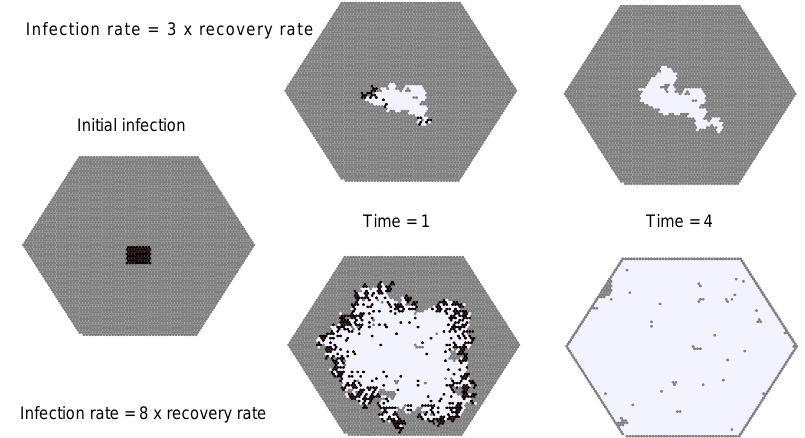
Figure 10. A susceptible–infectious–recovered (SIR) model built with CellLab-CTS. This example compares runs with two different infec- tion rates (top and bottom rows, respectively). Gray is susceptible, black is infectious, and white is recovered. One time unit is one average recovery time. This example model uses the HexCTS subclass (non-oriented model with hexagonal